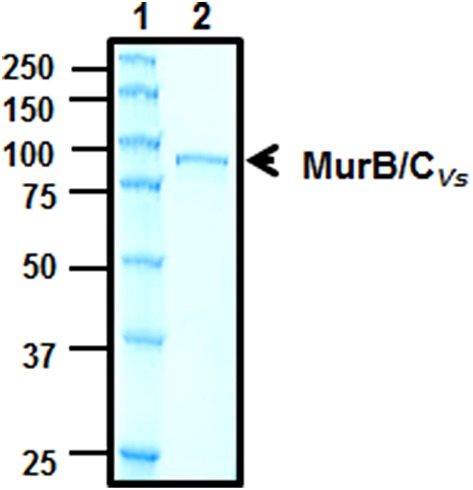
Purification of MurB/C by affinity chromatography. Lane (1), protein ladder (kDa). Lane (2), 0.5 μg of purified MurB/C. The proteins were resolved on a 10% (w/v) acrylamide gel and stained with Coomassie blue for visualization.